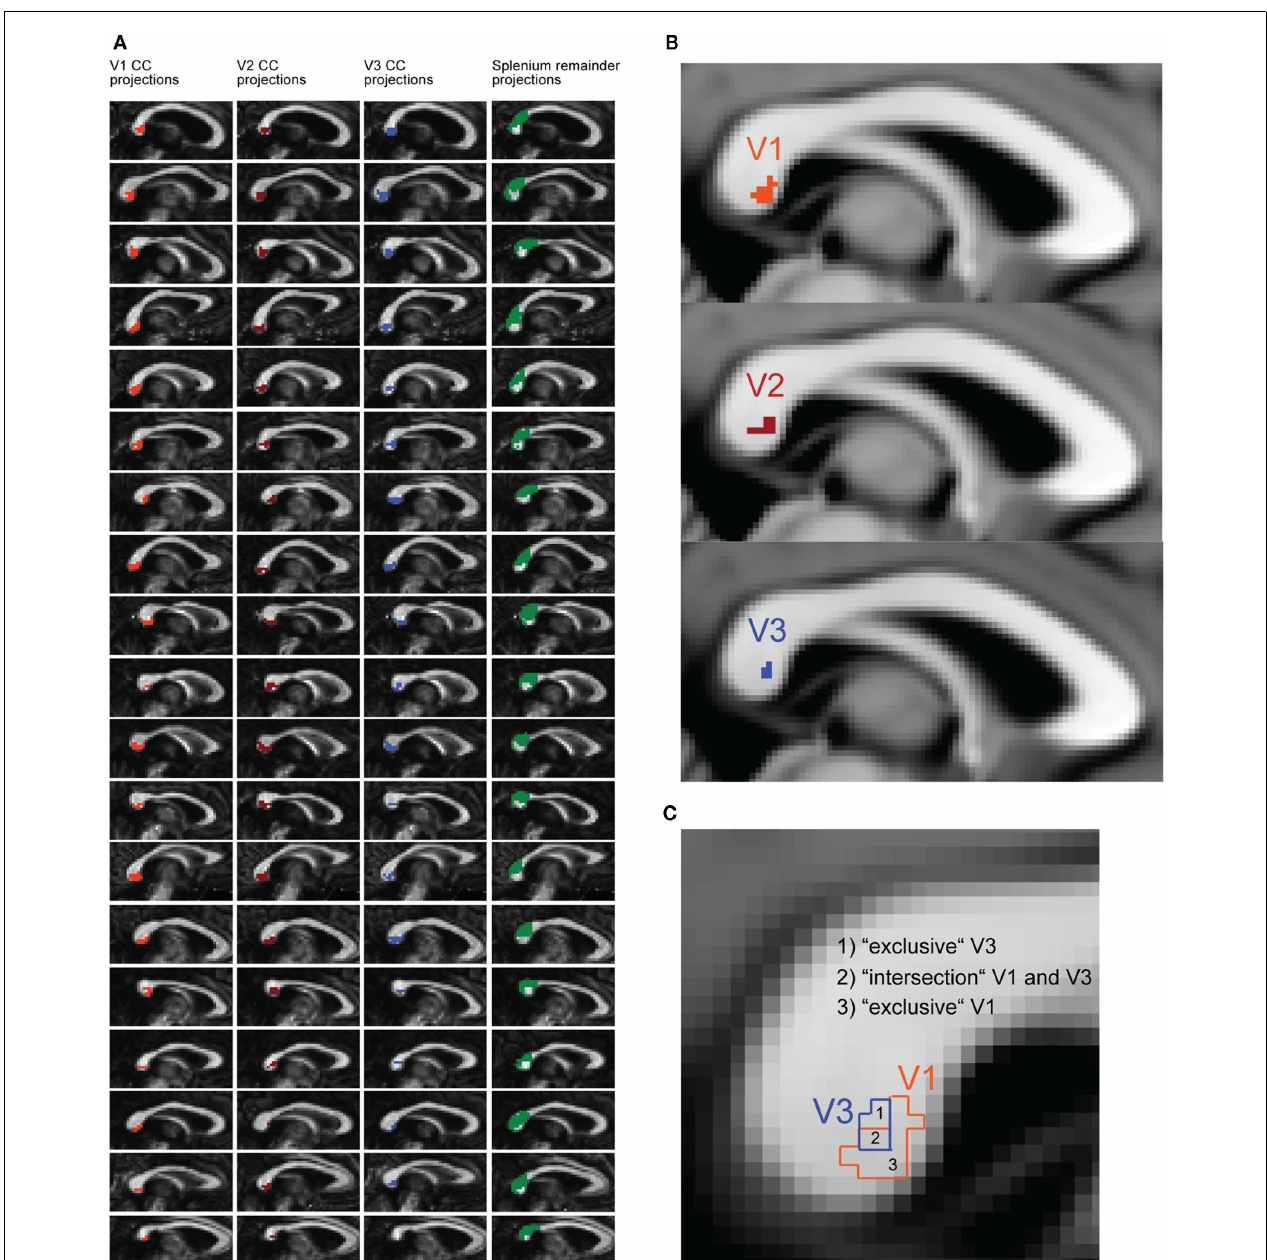
FIGURE 3 |Tractography results and schematic description of the parcellation logic for the transcallosal fibers. (A) Midsagittal tracking results of every participant overlaid on each individual’s corpus callosum (CC).Transcallosal fiber connections are plotted for regions that project to functionally localized regions ofV1 (orange),V2 (dark red), andV3 (blue). The green area represents the splenium, anatomically defined, excluding the projections fromV1,V2, andV3 (splenium remainder). (B) Display of the group-analysis results forV1 (orange),V2 (dark red), andV3 (blue) CC